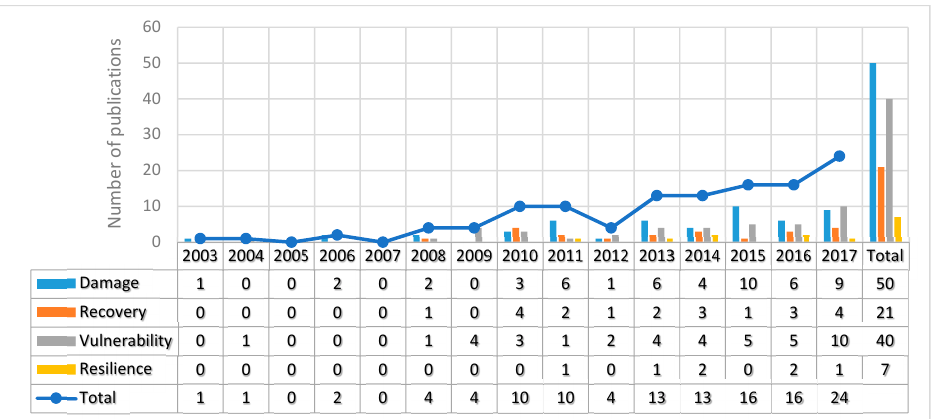
Figure 1. Number of annual publications on remote sensing-based proxies for Disaster Risk Management (DRM). Papers with a focus on two DRM areas, e.g., both damage and recovery assessments, are counted on both of them separately.